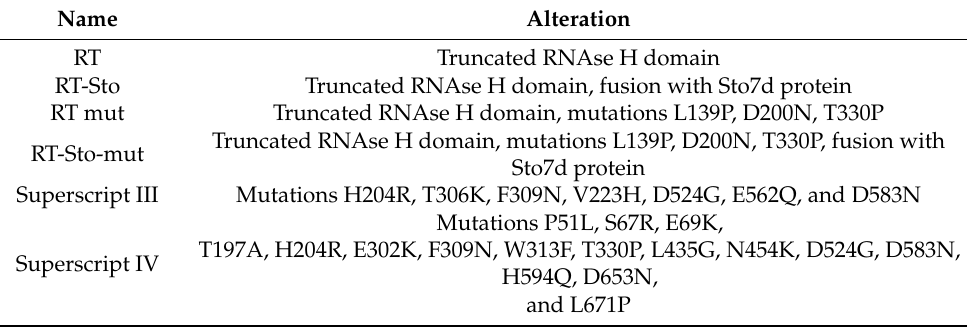
Table 1. Reverse transcriptases and their